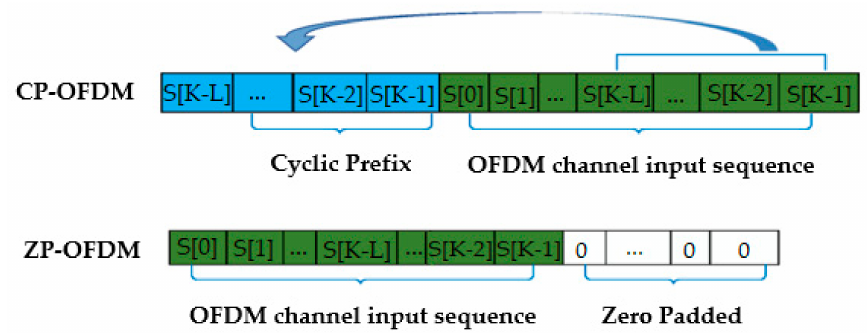
Figure 6. The transmitting process of ZP-OFDM and CP-OFDM